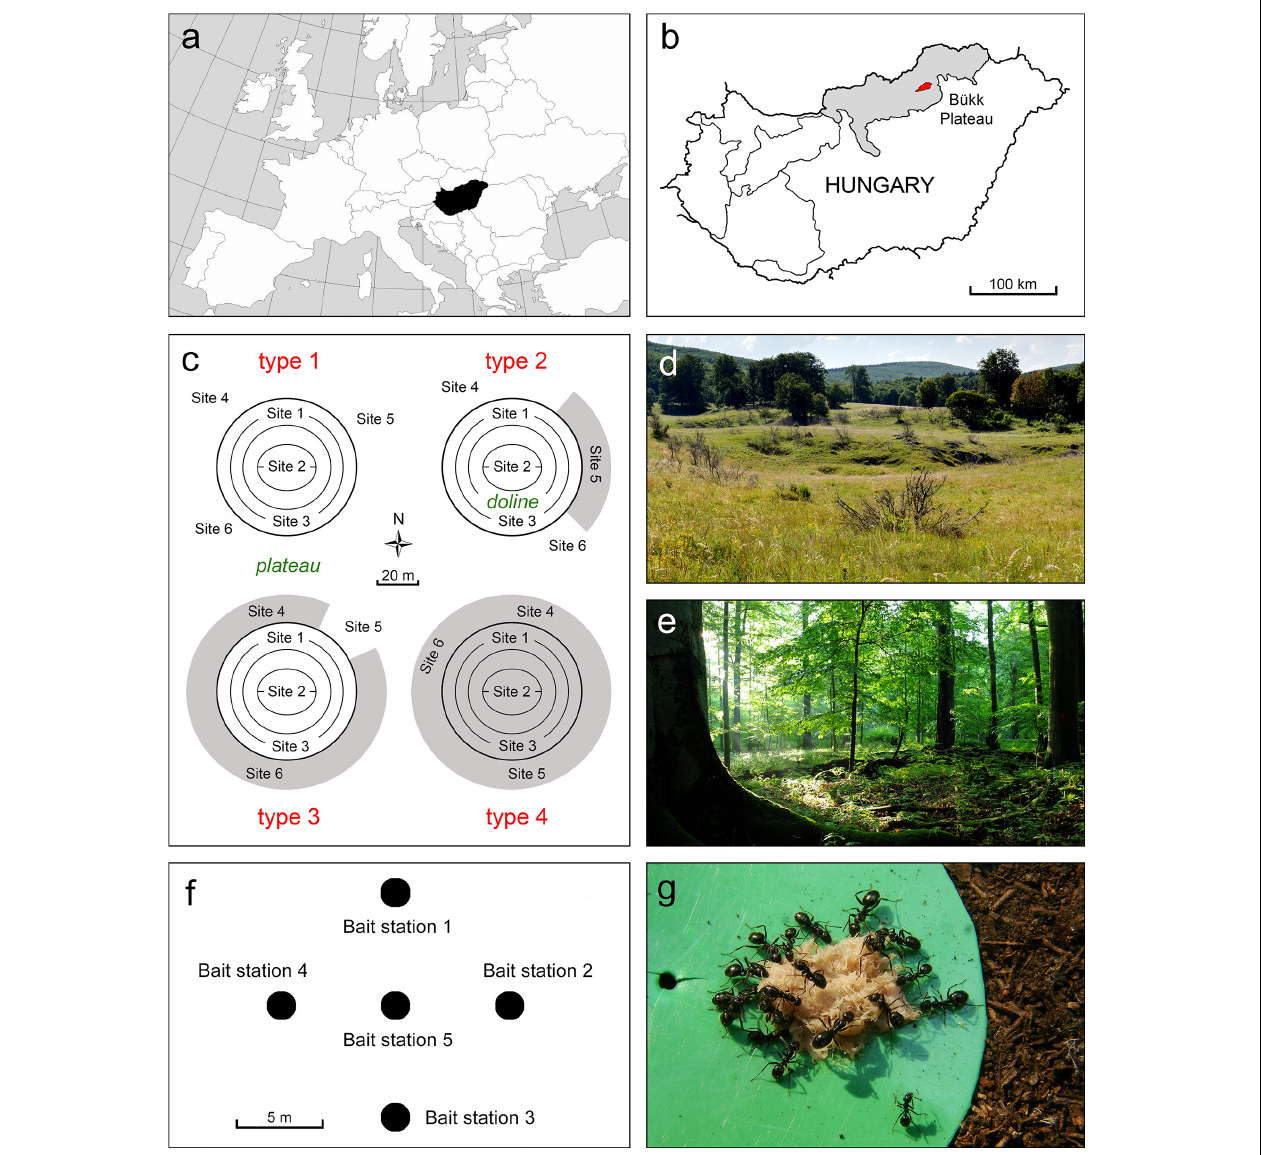
FIGURE 1 | Study region, study sites and sampling design. (a) Location of Hungary within Europe. (b) Location of the study region in Hungary. (c) Location of the study sites (site 1–6) in and around dolines. Forest cover is indicated by grey shading (doline types 2–4). (d) Grassland doline surrounded by grasslands. (e) Fagus sylvatica forest on the plateau. (f) Set-up of bait stations in a cross-shaped pattern. (g) Ants feeding on a bait.